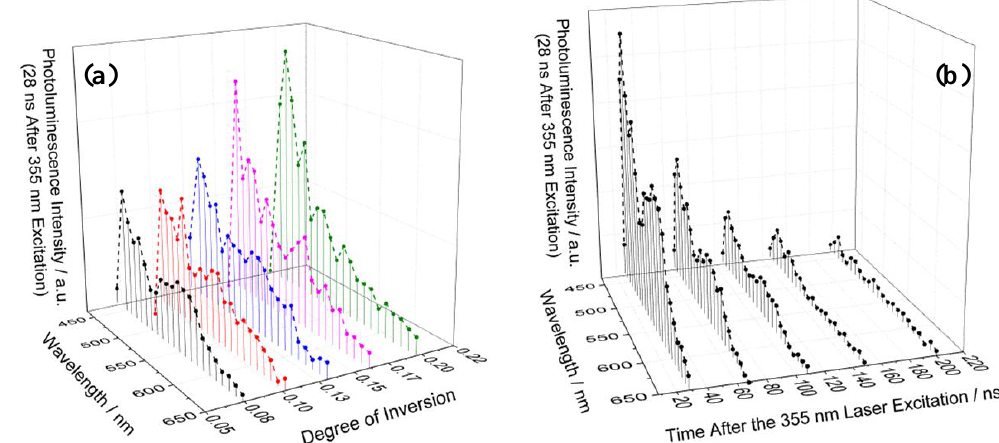
Figure 5. ( a ) Transient room-temperature photoluminescence spectra of the ZFO pellets as a function of the degree of inversion. The third harmonic (355 nm) of a Brilliant Nd:YAG laser with a pulse duration of 6 ns was used as the excitation source. The spectra were measured 28 ns after the excitation. x = 0.074 (ZFO_773); x = 0.104 (ZFO_873); x = 0.134 (ZFO_973); x = 0.159 (ZFO_1073); and x = 0.203 (ZFO_1173). ( b ) Transient room-temperature photoluminescence spectra of the ZFO pellet with x = 0.074